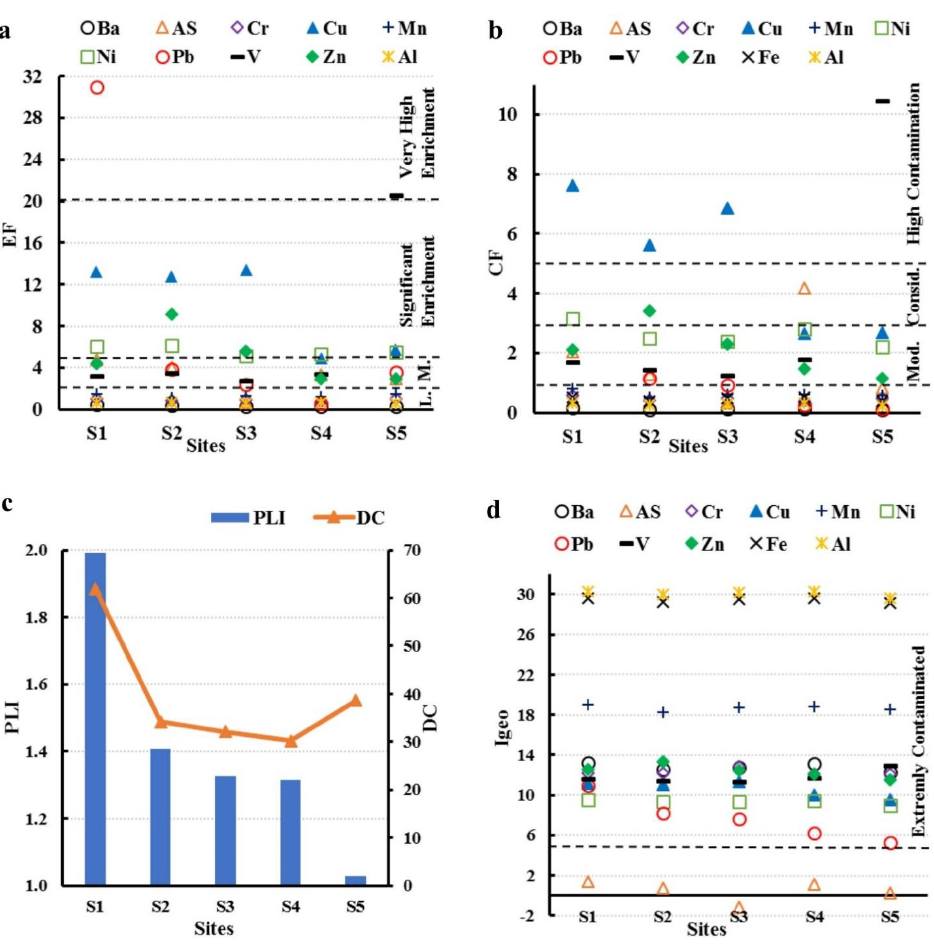
Figure 6. The average values of enrichment factor (EF; ( a )), contamination factor (CF; ( b )), geo − accumulation index (I geo ; ( c )), pollution load index (PLI), and degree of contamination (DC; ( d )) of the eleven studied heavy metals in sediments of Bahr El − Baqar drain. Table 5. The enrichment factor (EF) of the investigated metals in the drain sediment samples.